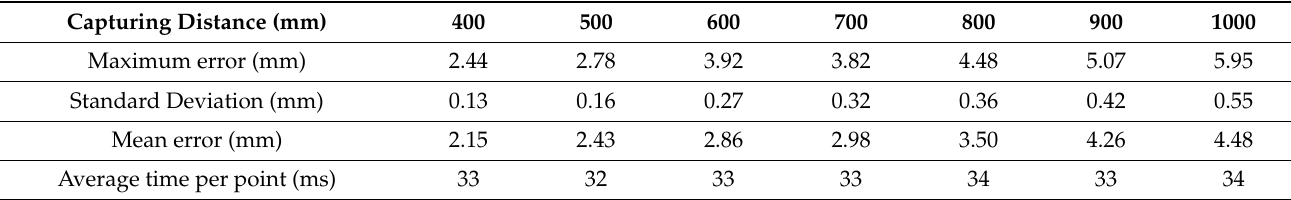
Table 1. Error indicators corresponding to our